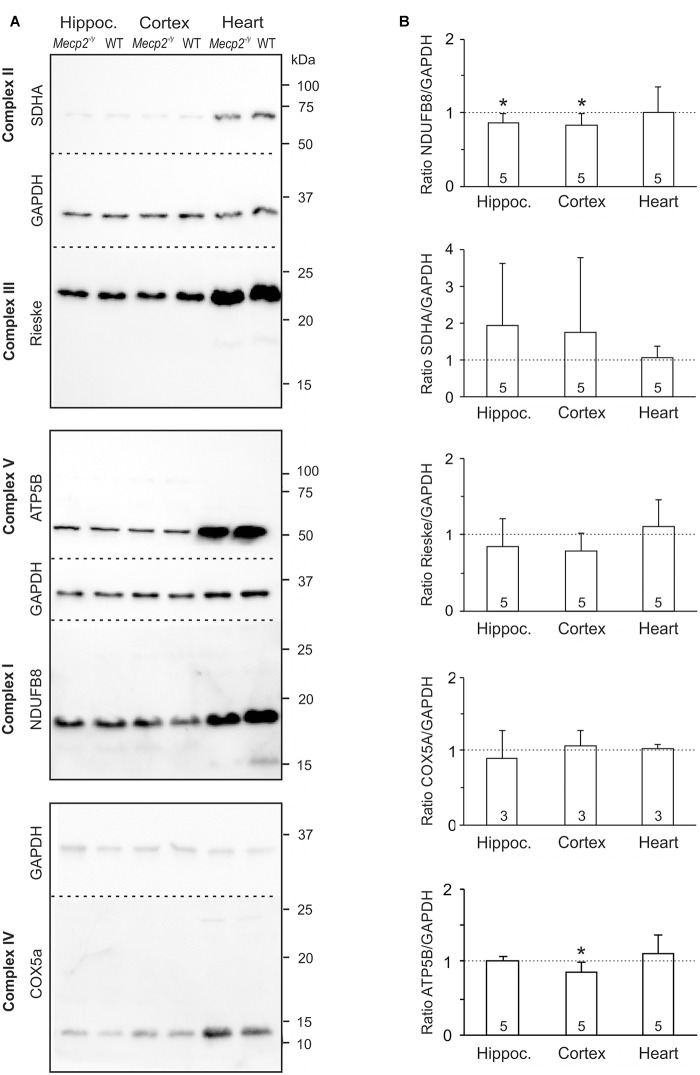
Protein expression levels of NDUFB8 and ATP5B differ only slightly between Mecp2-/y and WT mice. (A) Protein lysates were separated by SDS gel electrophoresis and analyzed by Western blotting, using antibodies specific against NDUFB8 (CI), SDHA (CII), Rieske (CIII), COX5A (CIV), ATP5B (CV), and GAPDH. Dashed lines indicate the membrane cut after protein blotting. The displayed blots of CII and CIII are from the same experiment and therefore share a common loading control; this also applies to CV and CI. (B) Expression levels of the proteins of interest were quantified by densitometry, normalized to GAPDH within the same tissue sample and then referred to the WT samples (defined as unity, see dashed line). The number of samples (mice) analyzed is reported; asterisks mark statistically significant differences as compared to WT in one sample t-tests (∗p < 0.05).